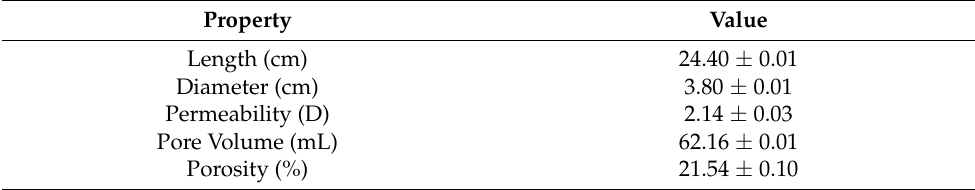
Table 1. Rock properties of the sandstone core material used in the experimental work.